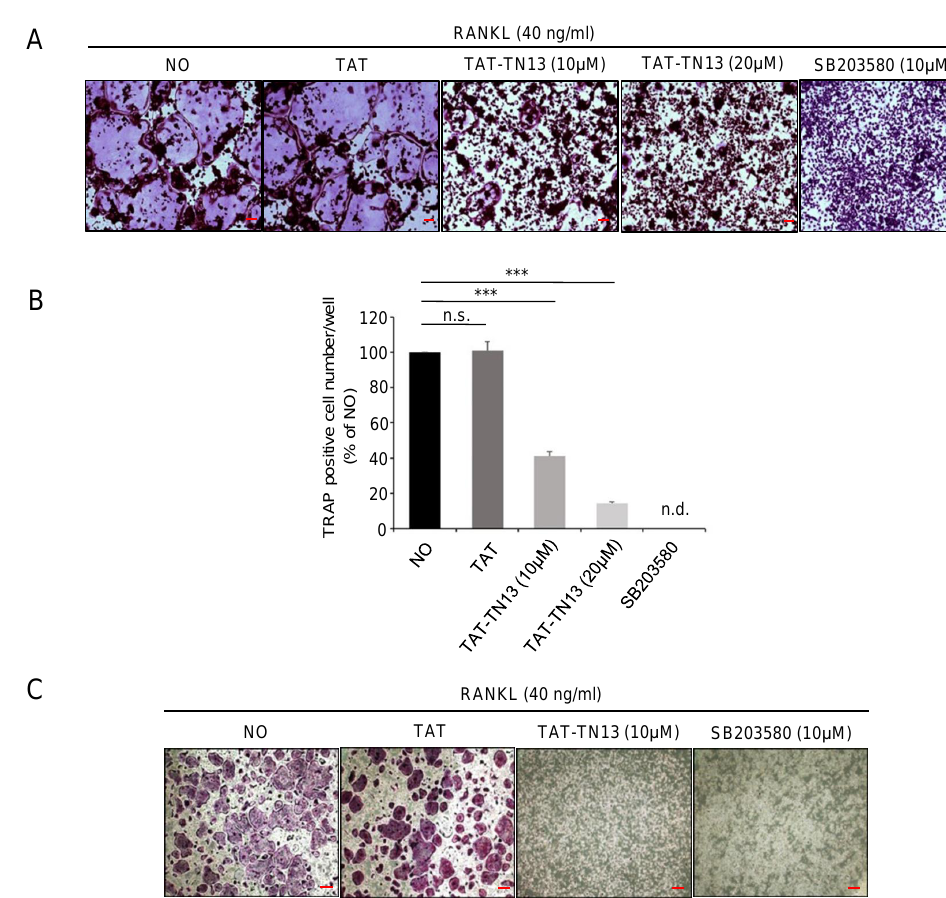
Figure 2. TAT-TN13 inhibits RANKL-induced osteoclast formation in a dose-dependent